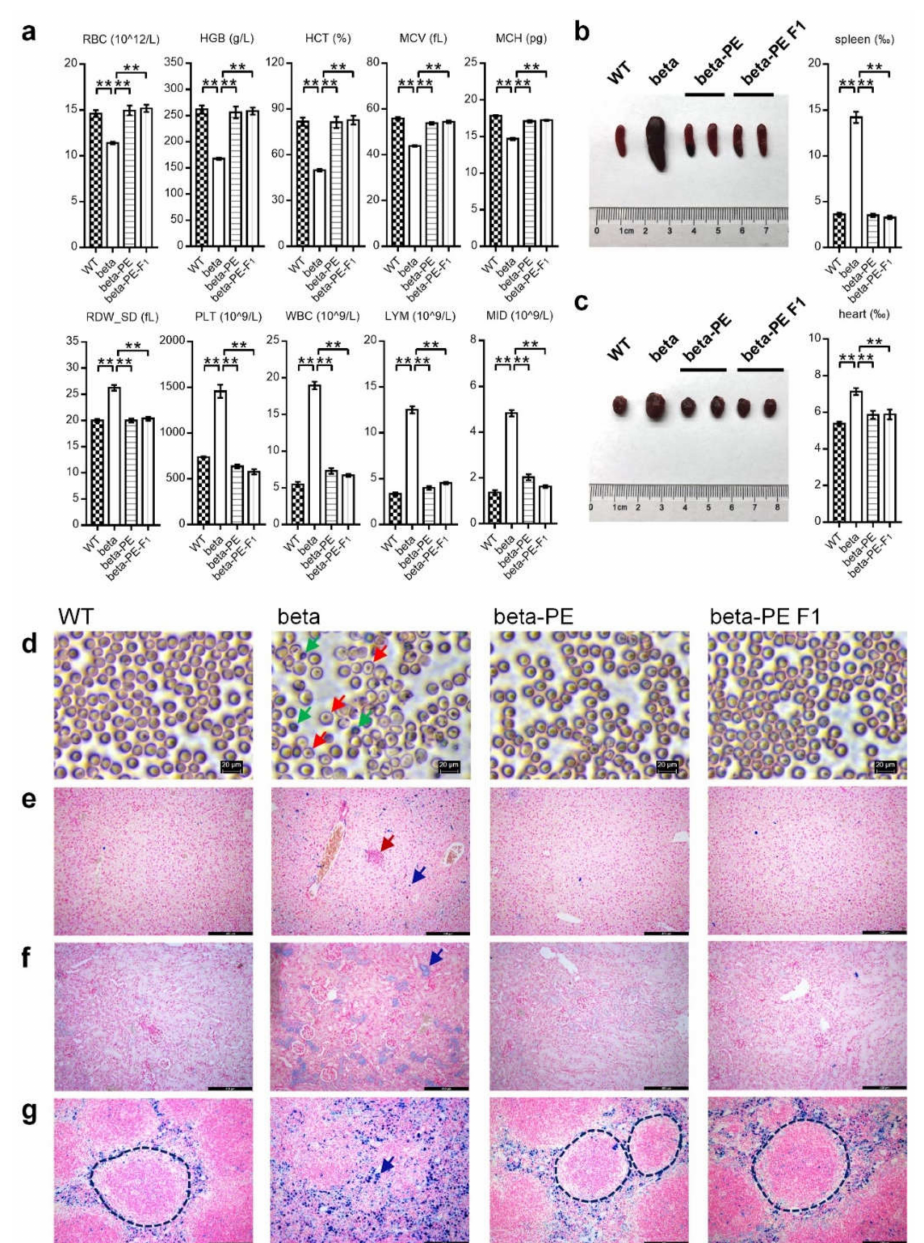
Figure 3. Characterization of beta-PE and beta-PE F1 mice. ( a ) Hematological analysis of red blood cell (RBC) count, hemoglobin (HGB) concentration, hematocrit (HCT), mean corpuscular volume (MCV), mean corpuscular hemoglobin (MCH), red cell distribution width_standard deviation (RDW_SD), platelets (PLT), white blood cell count (WBC), lymphocytes (LYM), and minimum inhibitory dilution (MID). Corresponding raw data are listed in Table S2. ( b , c ) Analysis of spleen ( b ) and heart ( c ) coefficients, respectively. The vertical axis shows the tissue coefficient (tissue coefficient ‰ = tissue mass/body mass × 1000‰). Corresponding raw data are listed in Table S3. Values given as mean ± standard error. ** p < 0.01 ( t -test). ( d – g ) Microscopic examination of Wright–Giemsa-stained blood smears ( d ) and ferrocyanide iron-stained sections of the liver ( e ), kidney ( f ), and spleen ( g ). Scale bars indicate 20 µ m in blood smears and 400 µ m in ferrocyanide iron-stained sections. Red and green arrows indicate target cells and poikilocytosis, respectively; crimson and navy arrows indicate extramedullary hematopoiesis and iron deposition, respectively; dotted line identifies white pulp in the